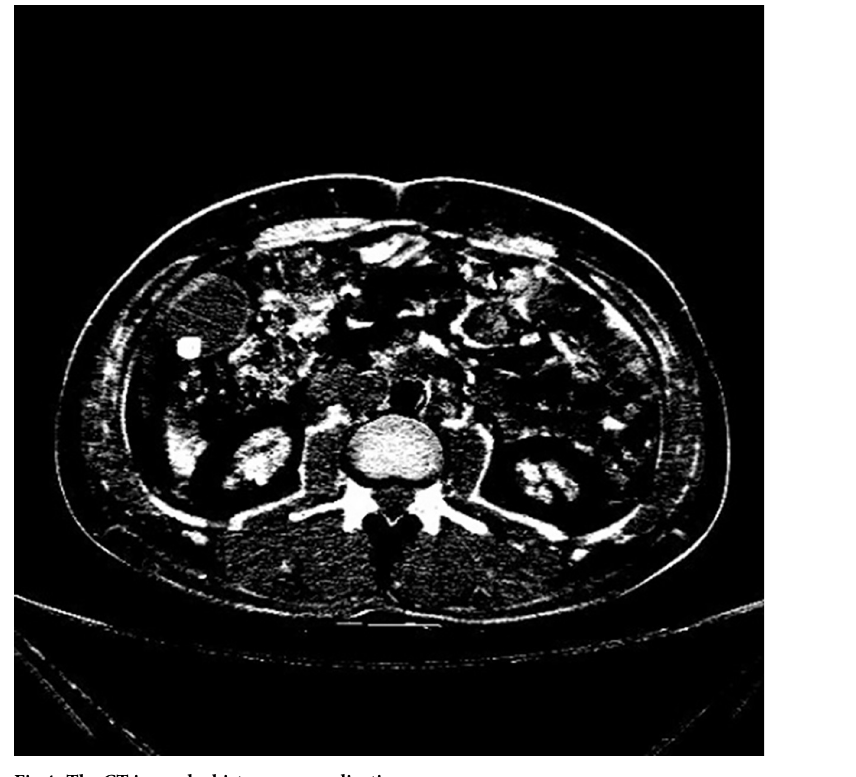
Fig 4. The CT image by histogram